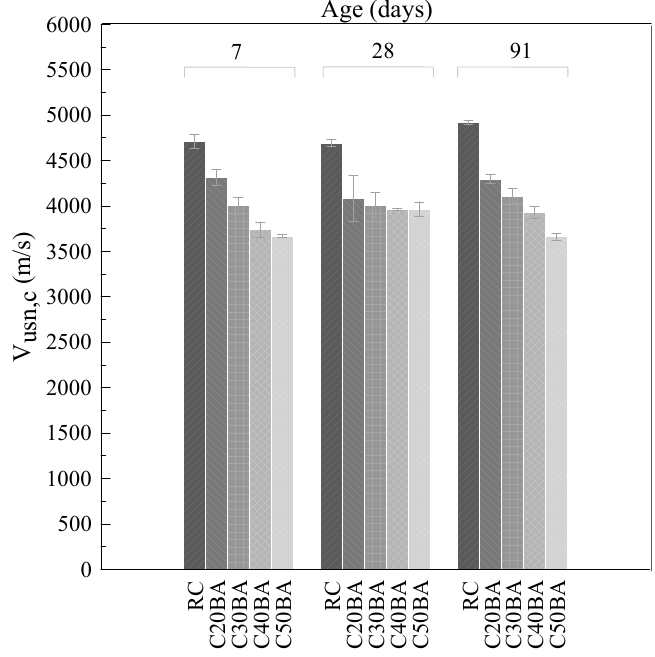
Figure 6. Ultrasonic pulse velocity at 7, 28 and 91